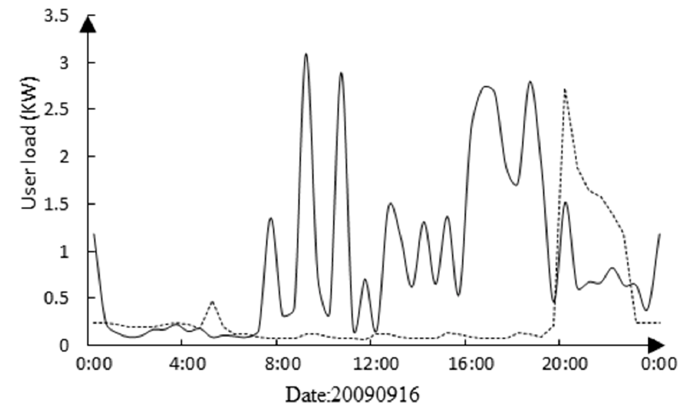
Figure 2. Load curves of two different domestic users on 16 September 2009.